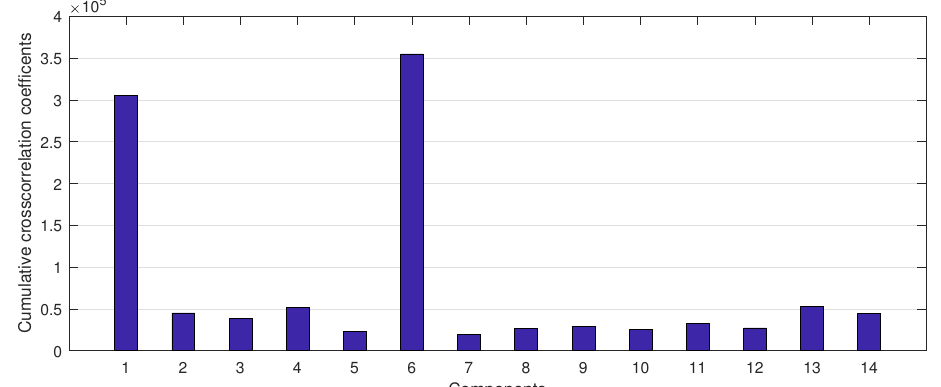
Figure 4. Example of cumulative cross-correlation coefficients between every IC and EOG, summed across trials, for subject S 12 .